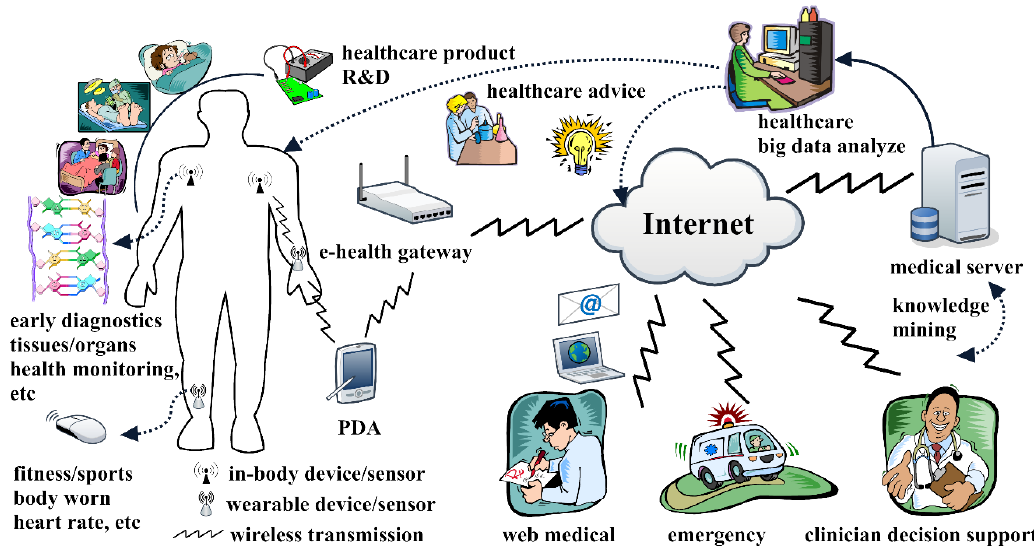
Figure 1. The proposed typical structure of the health IoT system.